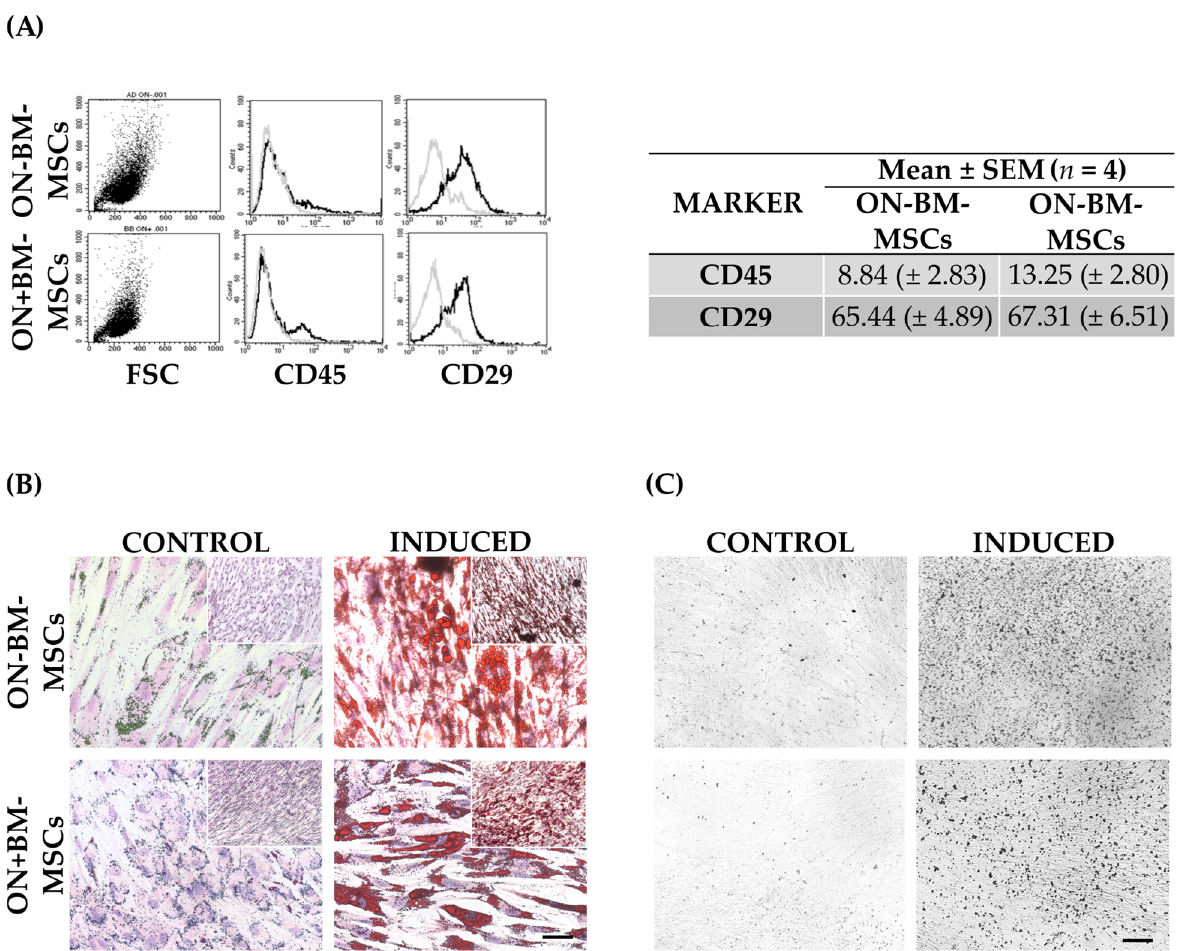
Figure 5. In vitro characterization and comparison of bone marrow-derived mesenchymal stromal/stem cells isolated before (ON-BM-MSCs) and after (ON+BM-MSCs) ON event. ( A ) Immunophenotypic profile using CD45 and CD29 antibodies and their expression in the two cell populations as mean ± SEM. ( B ) Oil red O staining to detect adipogenic in vitro differentiation of two MSC populations (10× in inset and 20× magnifications; scale bar 100 µm and 50 µm) and ( C ) Von Kossa staining to detect osteogenic in vitro differentiation of two MSC populations (10× magnification; scale bar 100 µm).